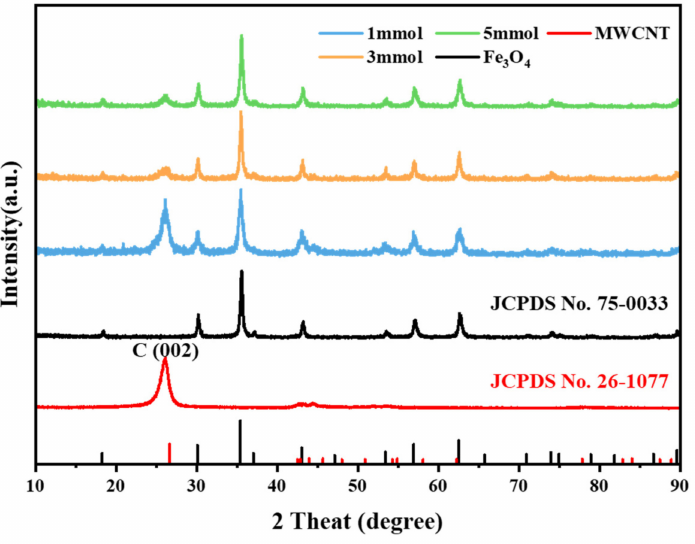
Figure 2. XRD patterns of Fe 3 O 4 , MWCNT and Fe 3 O 4/ MWCNT